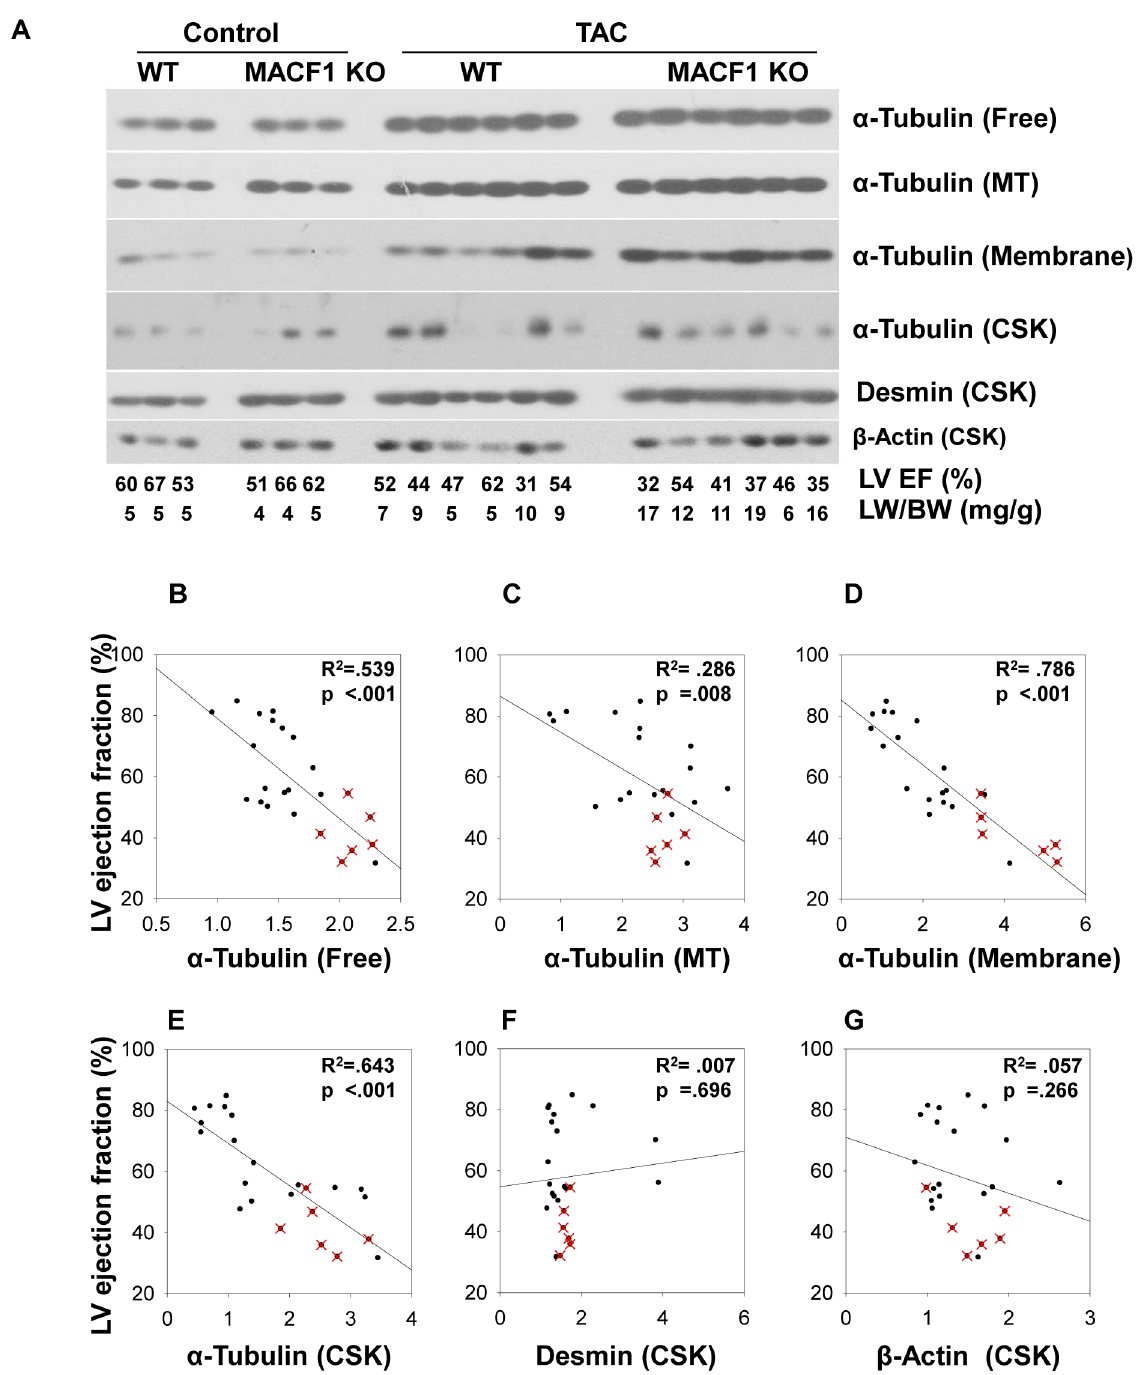
Figure 5. Maladaptive response to pressure overload is associated with redistribution of microtubules into distinct subcellular fractions. The relationship between LV ejection fraction and the levels of Tubulin, as well as b -actin, and Desmin, in different subcellular fractions (Figure 5A) was examined by linear regression analysis (Figure 5B–5G). The data was collected from 18 WT mice and 6 MACF1 KO mice exposed to TAC. Relative values of the protein levels were determined as fold increase over non-banded controls from the same experiment. Samples with a red x are MACF1 KO. doi:10.1371/journal.pone.0073887.g005 cytoplasm and was more reduced at the sarcolemma. Because bound vesicles that were not appropriately trafficked to the caveolin-3 levels are reduced in MACF1 KO hearts, but still very sarcolemma. abundant in the cell membrane fraction, it is possible that the PKC a is another protein that is regulated by the microtubule caveolin-3 observed in the cytoplasm is associated with membrane cytoskeleton [25,26] that is believed to play a role in pathological